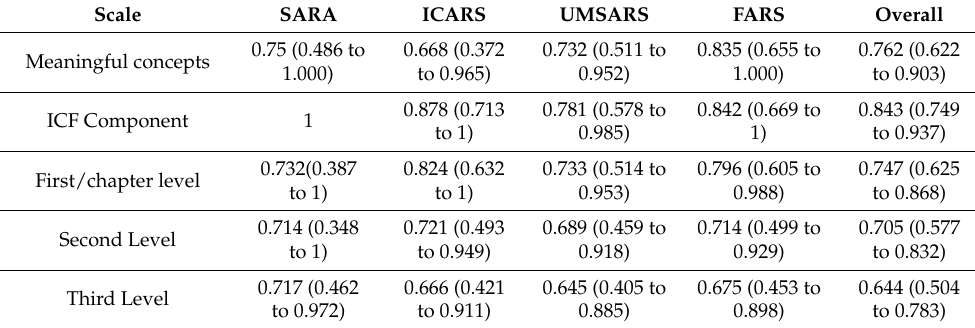
Table 3. Kappa agreement (95% confidence interval) at meaningful concepts, and ICF categories for the ataxia rating scales. ICARS, international cooperative ataxia rating scales; FARS, Friedreich’s ataxia rating scale; SARA, scale for assessment and rating ataxia; UMSARS, unified multiple system atrophy rating